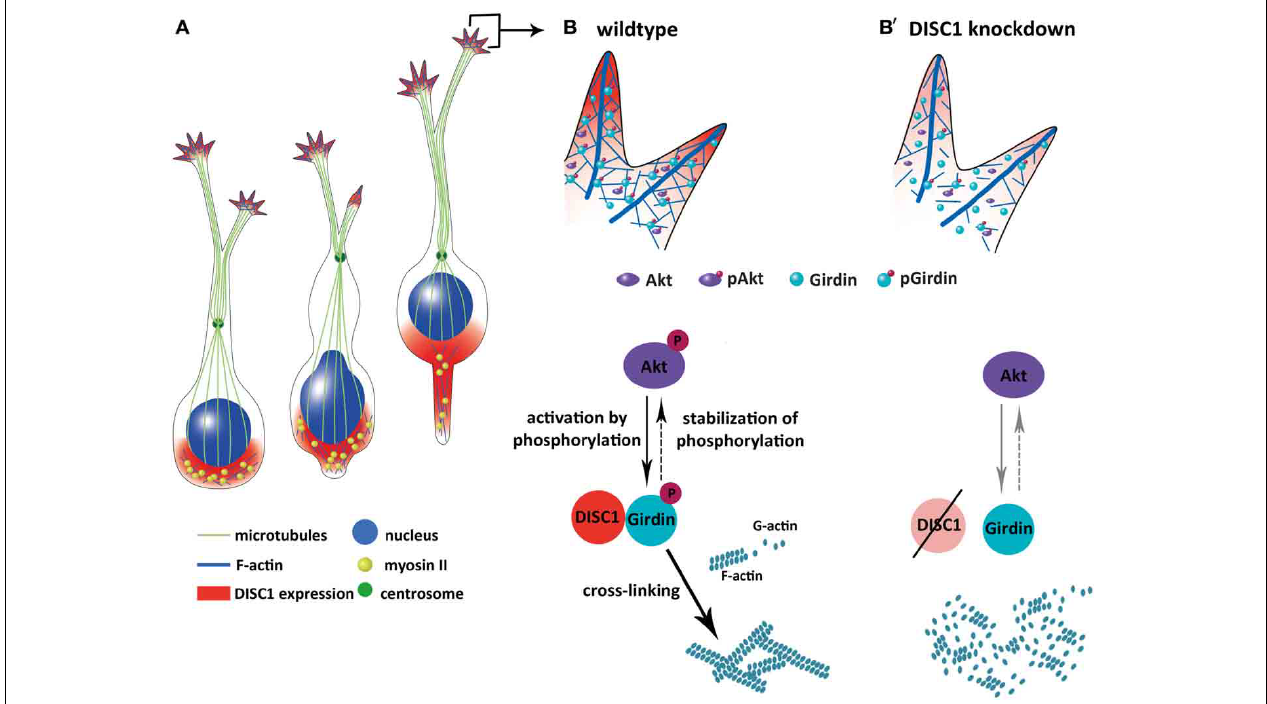
FIGURE 9 | Model how DISC1 orchestrates the tangential migration of cortical interneurons. (A) Soma translocation during tangential migration. DISC1 co-localizes with F-actin behind the nucleus and in the growth cone-like structure, where actin forces drive soma translocation. (B,B (cid:2) ) Interaction of DISC1 with Girdin provides a possible link between DISC1 and actin reorganization which is necessary for correct soma translocations. In wildtype interneurons (B) , phosphorylated forms of Akt and Girdin lead to cross-linked F-actin. In the absence of DISC1 (B (cid:2) ) , the amount of phosphorylated Akt as well as Girdin is decreased, an effect